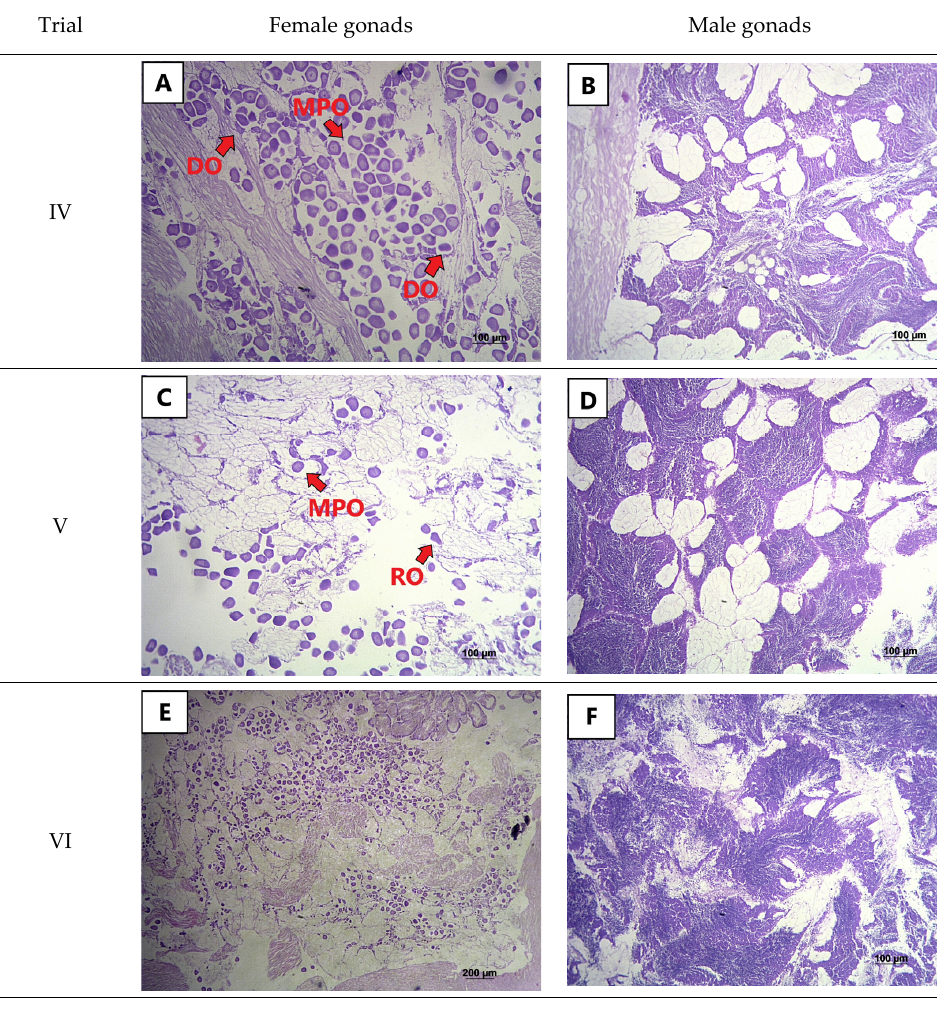
Figure 2. Histological analysis of the gonadal tissues of laboratory ‐ unconditioned yellow clam ( Amarilladesma mactroides ) exposed to different spawning ‐ inducing treatments in trials IV, V, and VI: ( A ) Partial spawning stage (Stage 5) of a female clam presenting free mature, polygonal oocytes (MPO) and deteriorating oocytes (DO); ( B ) Partial spawning stage of male clam from trial IV; ( C ) Partial spawning stage (Stage 5) of a female with mature, polygonal oocytes (MPO) and rounded residual oocytes (RO); ( D ) Male yellow clam in the partial spawning stage (stage 5); ( E ) Female clam in the partial spawning stage (stage 5) displaying free mature, polygonal oocytes and a large number of rounded oocytes; ( F ) Male clam in the partial spawning stage (stage 5).